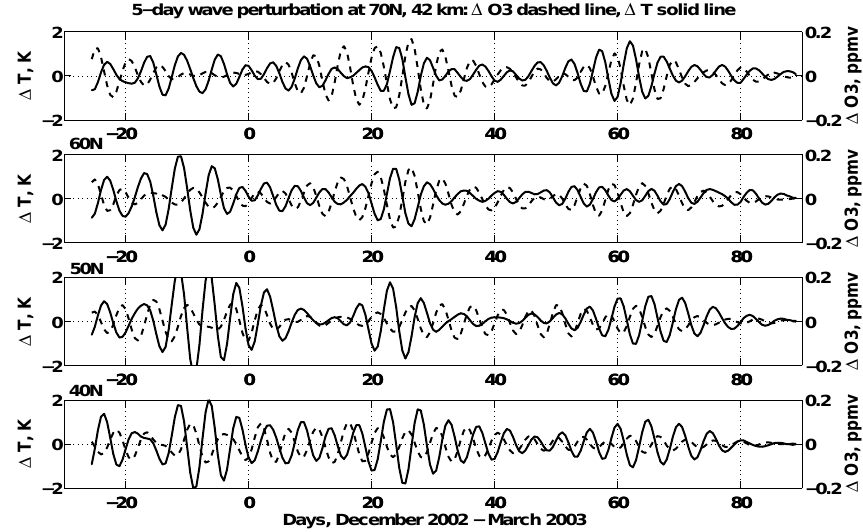
Fig. 9. The 5-day wave perturbation in temperature (left scale, K) and ozone (right scale, ppmv) at 42km from Odin SMR data at 70 ◦ N, 60 ◦ N, 50 ◦ N, 40 ◦